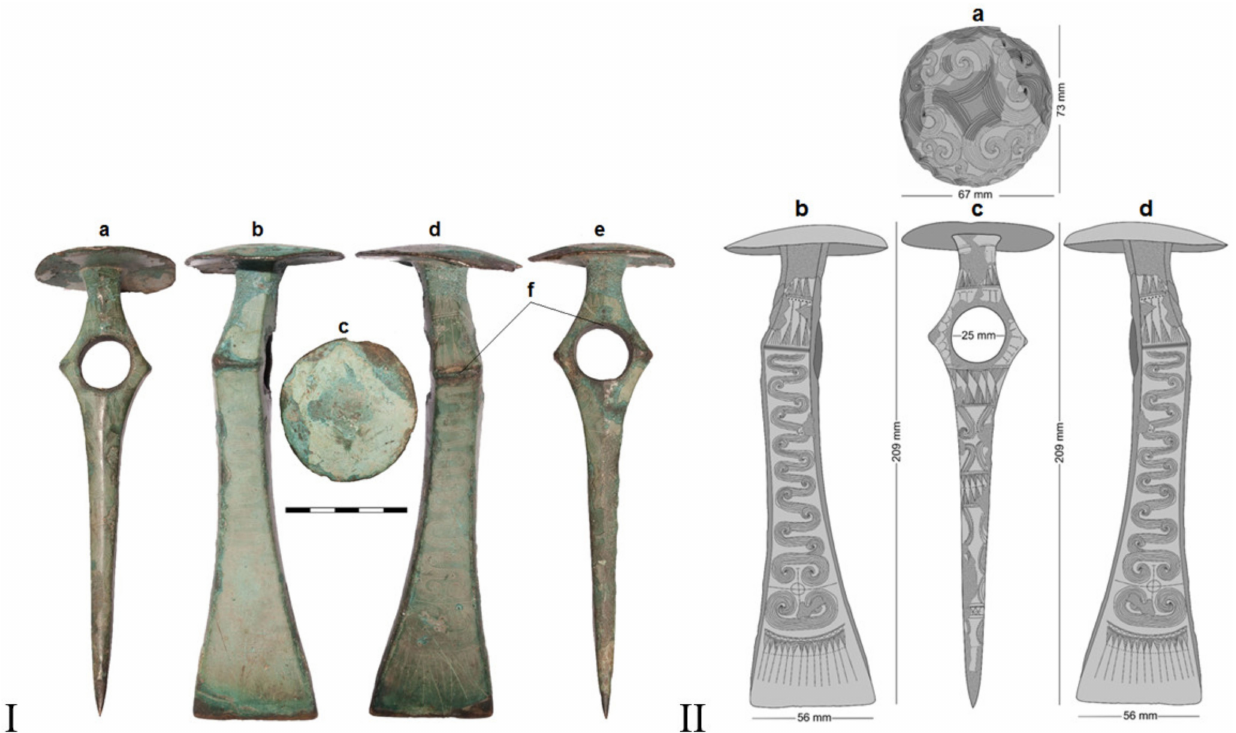
Figure 1. Disc-butted axe [3]: I—photographs: a—upper narrow side; b—front side; c—disc: d—back side; e—lower narrow side; f—sampling area; II—reconstruction by author’s drawing: a—disc; b—left side; c—edge (narrow face); d—right